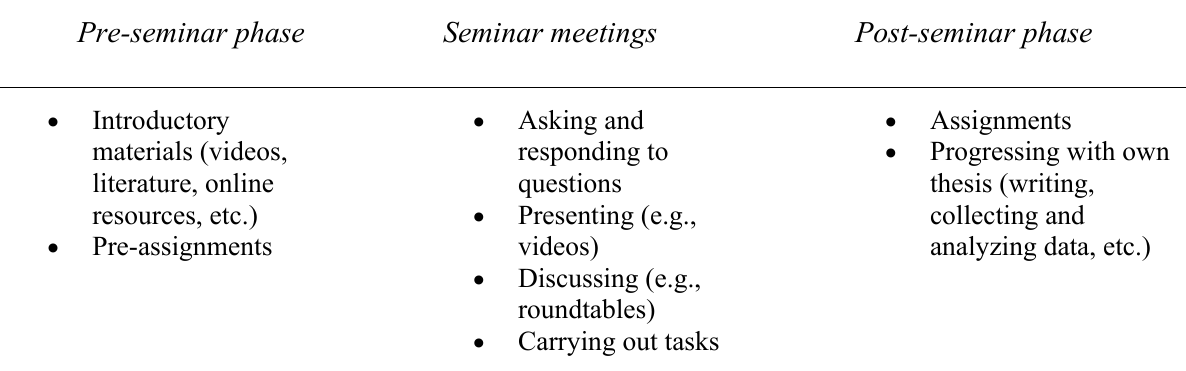
Application of the FC approach in the master’s thesis seminar Pre-seminar phase Seminar